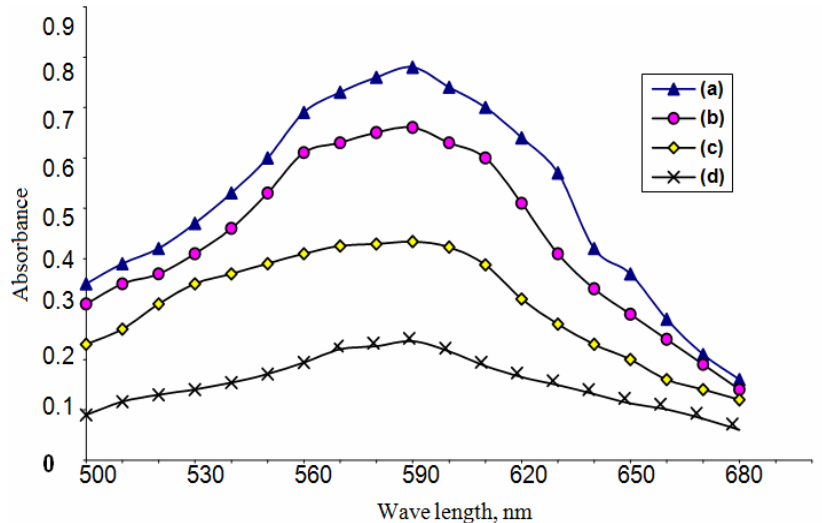
Figure 1. Absorption spectra of the CAT – iodine -starch complex with ISH (a) Blank (without ISH) (b) 0.5 µ g mL -1 (c) 1.5 µ g mL -1 (d) 2.5 µ g mL -1 measured against